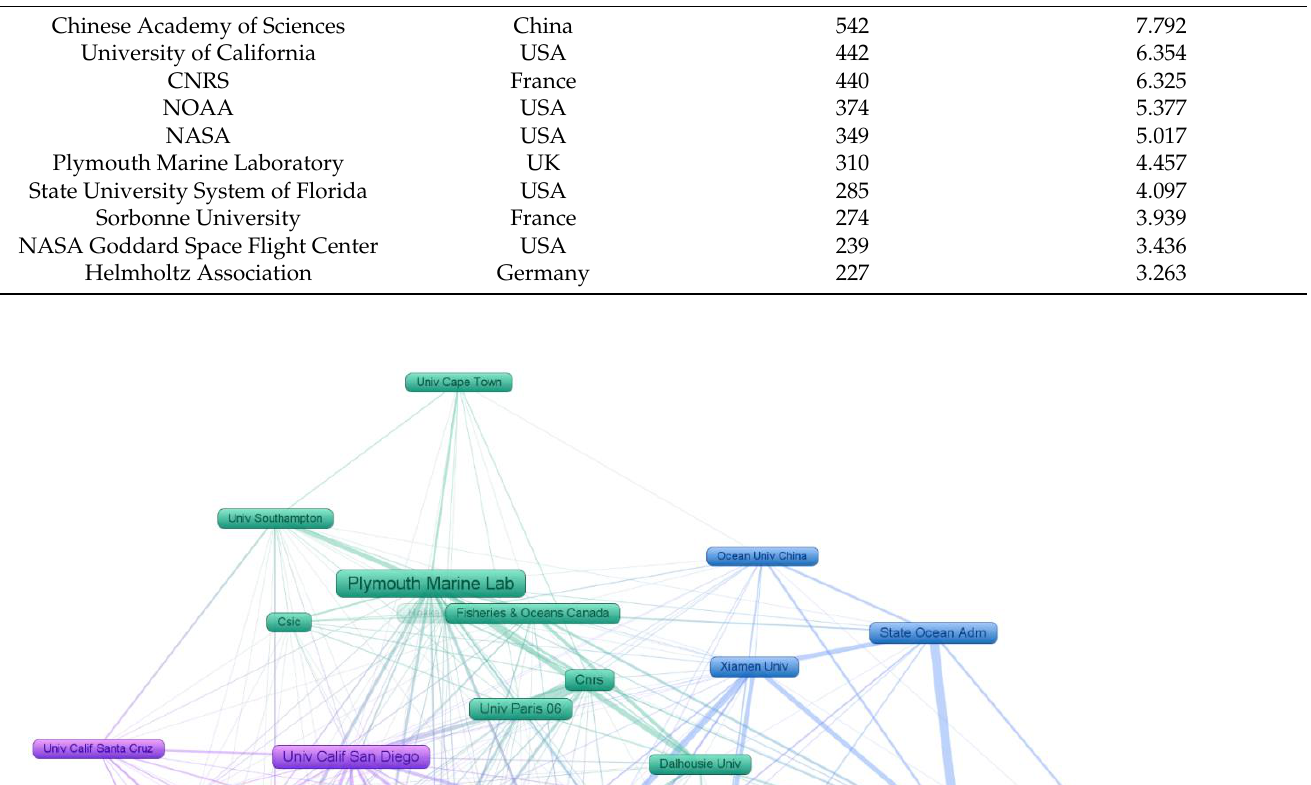
Table 3. The top 10 most productive institutions and the country in which they were located and the number and percentage of papers from 1990 to 2020.